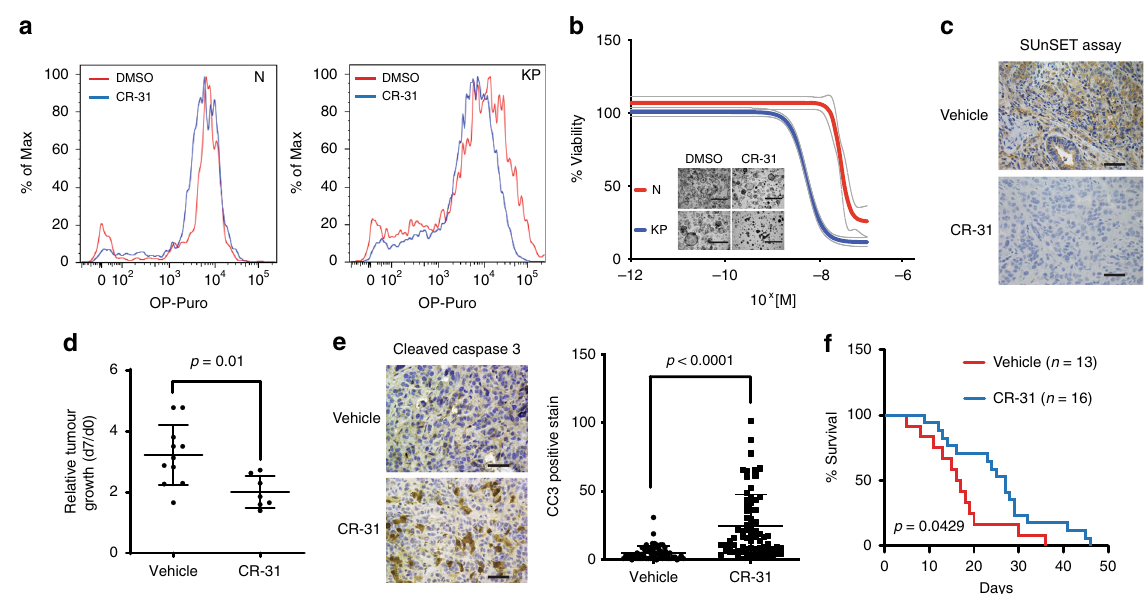
Fig. 1 The eIF4A inhibitor CR-31 potently targets pancreatic ductal adenocarcinoma. a Normal (N), and Kras G12D ;p53 R172H (KP) organoids were treated with 10 nM CR-31 for 60 min and compared to vehicle (DMSO). During the last 30 min, 10 μ M O -propargyl-puromycin (OP-Puro) was supplemented into the media. Dissociated single cells were fi xed, stained by CuAAC with Alexa488-azide and the level of OP-Puro conjugation within polypeptide chains was quanti fi ed by fl ow cytometry. b Cell viability of N and KP organoids upon a 72 h treatment with increasing concentrations of CR-31. Dotted lines indicate 95% con fi dence intervals ( n = 5). Inset shows representative images of organoids treated with 10 nM CR-31 for 72 h. Scale bars, 1000 μ m. c SUnSET assay of representative PDA tumours from mice following 7 daily treatments with vehicle (5.2% PEG-400/5.2% Tween80) or 0.2 mg kg − 1 CR-31. Mice were euthanized for tissue collection 2 h after the fi nal treatment with vehicle or CR-31 and 30 min after 40 nmol g − 1 puromycin injection. Scale bars, 50 μ m. d Relative tumour volume of PDA-bearing mice after 7 daily treatments with 0.2 mg kg − 1 CR-31 or vehicle. Relative growth was estimated by comparison of tumour volume 7 days post injection to that at pre-enrolment (day 0) by ultrasound imaging. Data are mean + / – S.D. Student ’ s t -test. ( n = 11, vehicle; n = 7, CR-31). e Immunohistochemistry of cleaved caspase 3 (left) in representative tumours from mice treated daily for 7 days with vehicle or 0.2 mg kg − 1 CR- 31 together with quanti fi cation of cleaved caspase 3 (right) from n ≥ 7 fi elds of view. Data are mean + / – S.D. Student ’ s t -test. Tissues were harvested 2 h post fi nal treatment. Scale bars, 50 μ m. f Kaplan – Meier survival analysis for Kras G12D ;p53 R172H ;PdxCre (KPC) mice treated daily with vehicle ( n = 13)